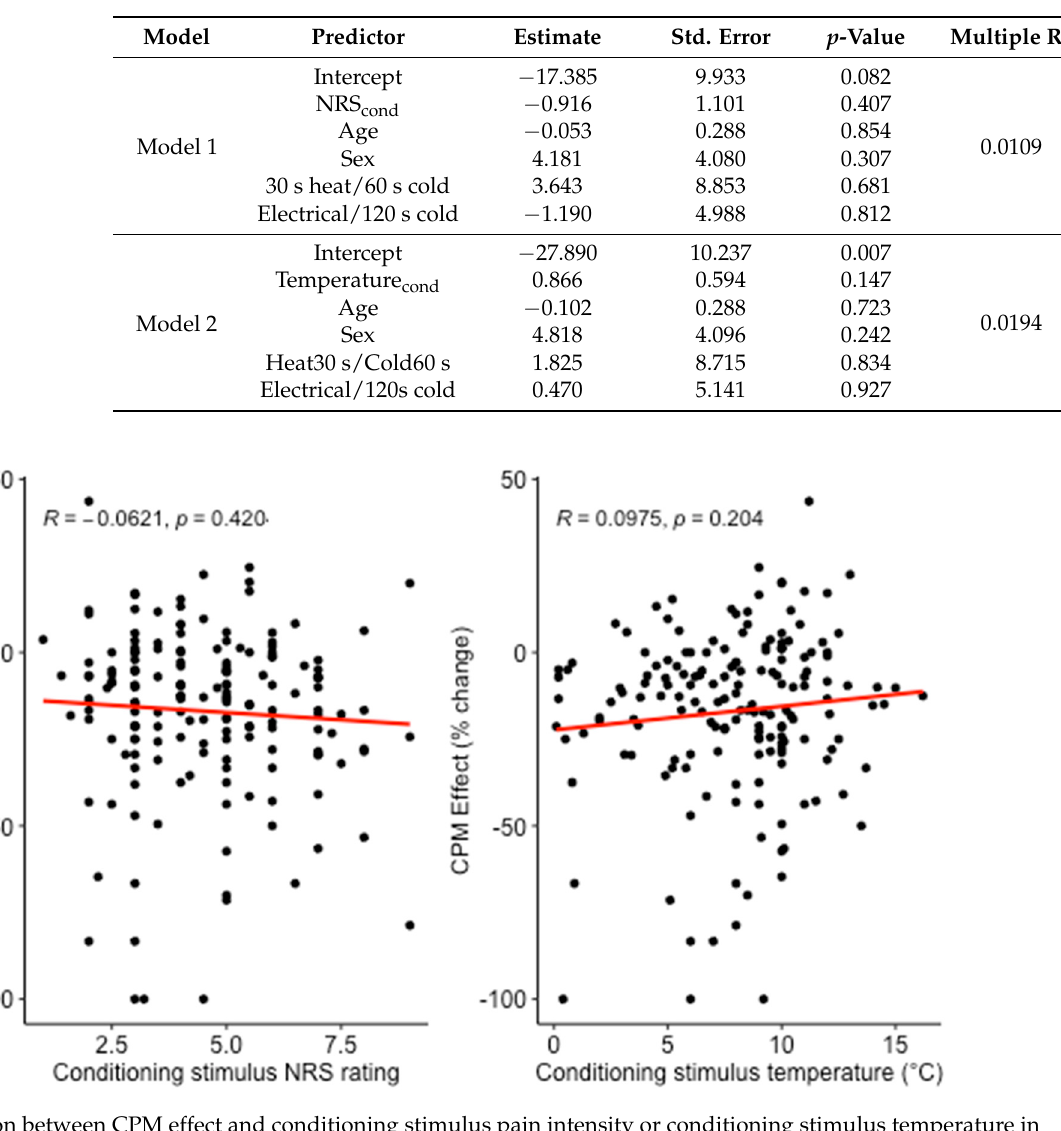
Table 2. Results of linear regression analysis of the cross-sectional data (n = 171). See Methods for construction of models 1 and 3. NRS cond, CS pain intensity rating on the NRS [0–10]. Temperature cond , temperature of the CS (cold water bath). Fixed effects of sex and paradigm were compared to a reference (male and 30 s heat/60 s cold, respectively).